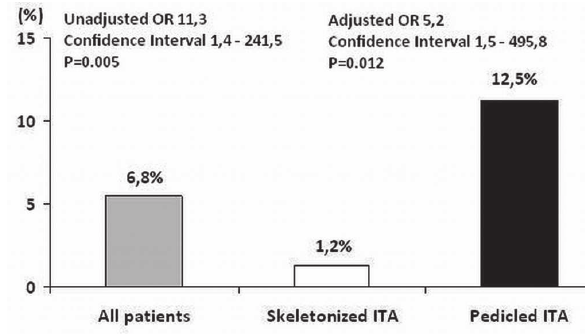
Fig. 6 – Incidence of mediastinitis in elderly after CABG and comparison between groups. ITA = internal thoracic artery; CABG = coronary artery bypass graft; OR = Odds Ratio. The adjusted OR was obtained comparing pedicled ITA group with skeletonized ITA group, taking into consideration differences between groups about preoperative, intraoperative and postoperative